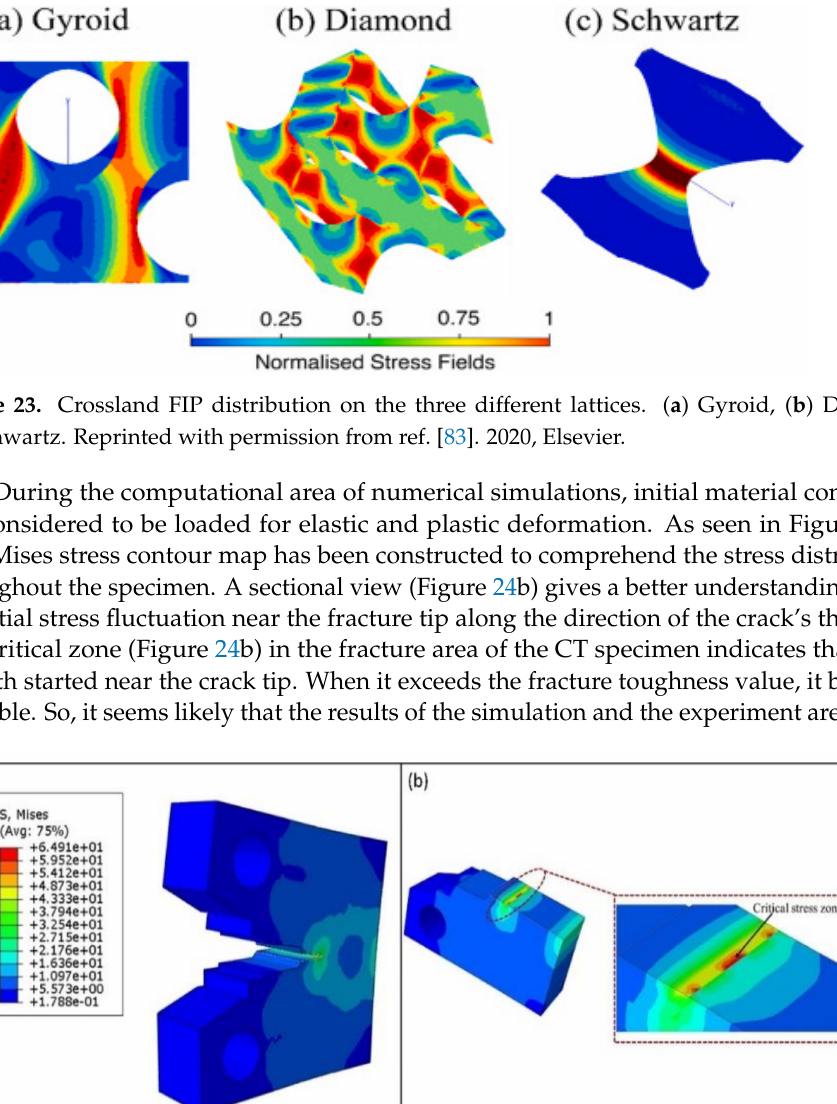
25 of 38 Figure 22. Subsurface pore of diameter d: ( a ) stress concentration factor, Kt vs. distance, x to free surface (point A, marked as dot), ( b , c ) overall model (top left corner) and enlarged view of local stress distribution under applied unit stress in the Z-X plane; x = 0.2 d, Kt = 2.52 in ( b ), x = 0.5 d, Kt = 2.18 in ( c ). Reprinted with permission from ref. [77]. 2018, Elsevier. The distribution of the Crossland fatigue indicator parameter (FIP) for three geometries is shown in Figure 23. In terms of FIP localization, it is evident that Schwartz